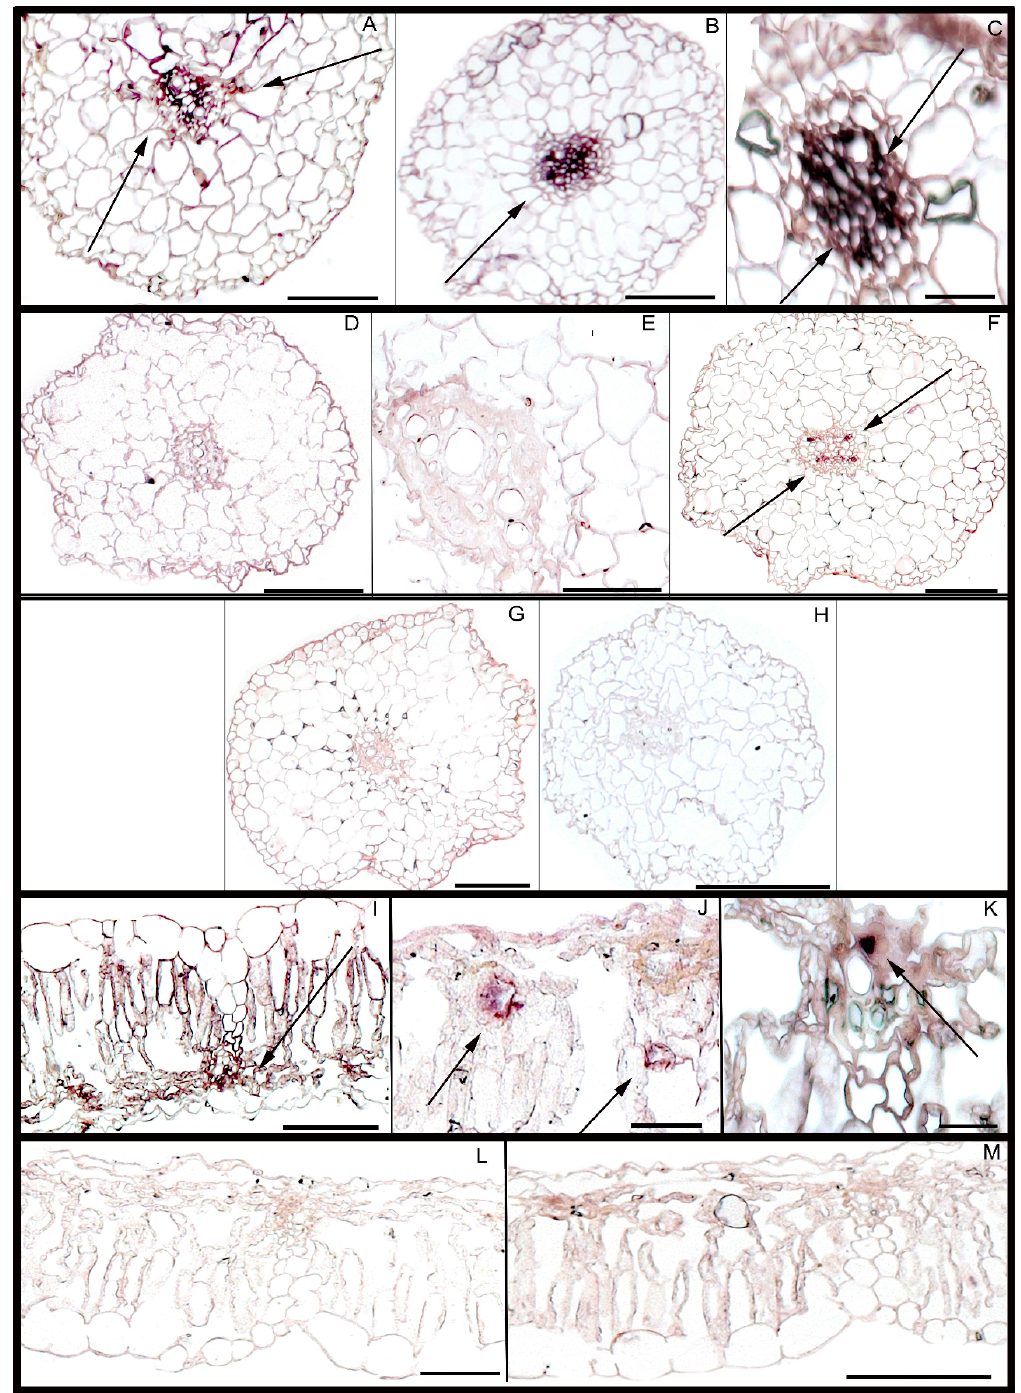
Figure 2. In situ distribution of AsDUF538 transcripts in Arachis spp. In situ spatial and temporal distribution of AsDUF538 transcripts in semi-thin plastic sections of roots and leaves of A. stenosperma and A. hypogaea plants inoculated, or not, with M. arenaria J2. In situ hybridization evident signals (dark purple) in cells of the vascular cylinder (arrows) of ( A , B ) A. stenosperma at 3 DAI and ( C ) 6 DAI, but lacking ( D , E ) in A. hypogaea 3 DAI, with some transcripts detected at 6 DAI ( F ). No signals were observed in roots of mock-inoculated plants for both species, as demonstrated ( G ) by A. stenosperma at six days after start of the bioassay. No signal was observed with the control sense probe (T7) in root sections of both species, as demonstrated ( H ) by the root section of A. hypogaea at 6 DAI. In situ hybridization in sections of leaves ( I – K ) from inoculated A. stenosperma plants at 6 DAI, with signals present in different cells, mostly concentrated in the cells of the vascular cylinder (arrows), whilst in ( L , M ) A. hypogaea plants, leaves lacked signal detection. Bars = 100 µ m ( B , H , K , L ); 50 µ m ( A , D , F , G , H ); 20 µ m ( C , E , J ) and 10 µ m ( I